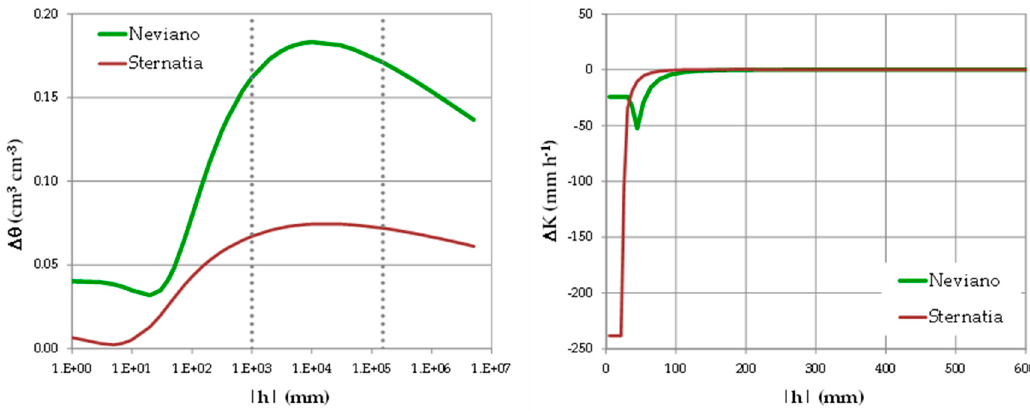
Figure 8. Differences in soil water retention ( Δθ ) and in hydraulic conductivity ( Δ K ) as a function of soil pressure head ( h ) for Neviano (differences between clay and sandy-loam) and Sternatia (differences between no-tillage and minimum tillage). Vertical bars represent θ values at field capacity and wilting point.